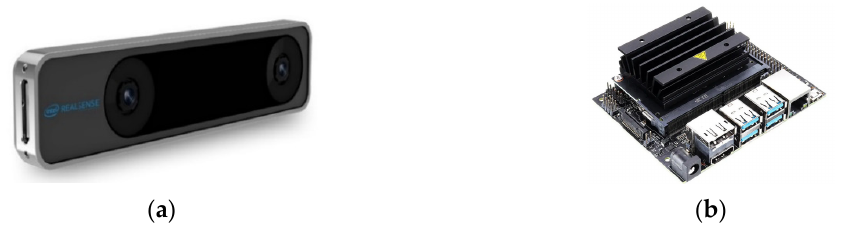
Figure 3. Position sensing equipment: ( a ) Realsense T265 tracking camera. ( b ) Jetson nano A57 companion computer.